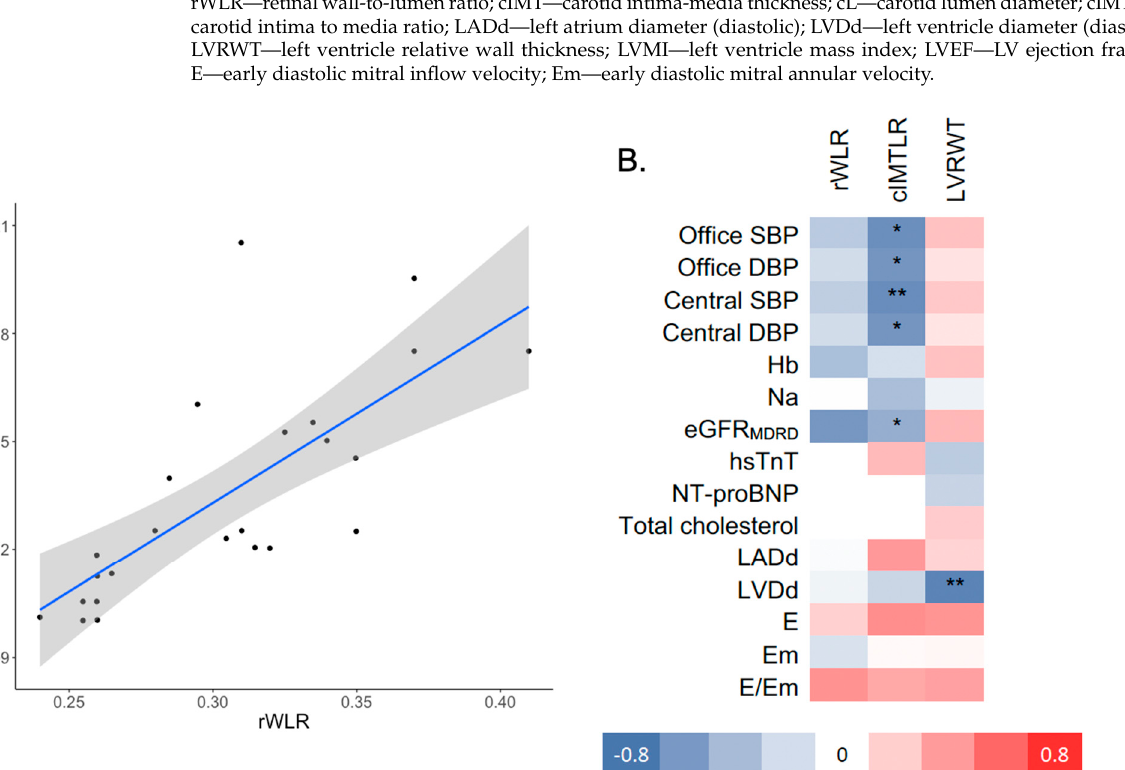
Values are expressed as median and interquartile range. ∆ stands for difference in median between HFpEF and control groups. p stands for Mann–Whitney U-test. HFpEF—heart failure with preserved ejection fraction;